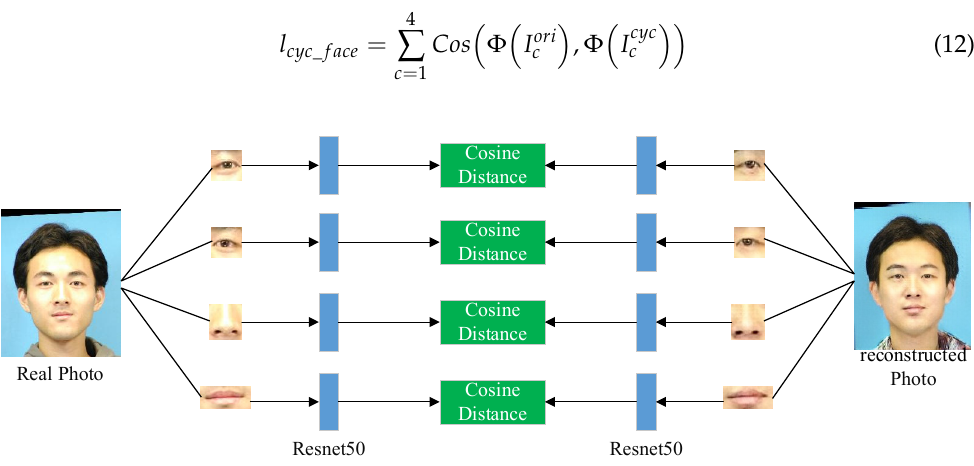
Figure 6. Loss calculations with facial detail retained.